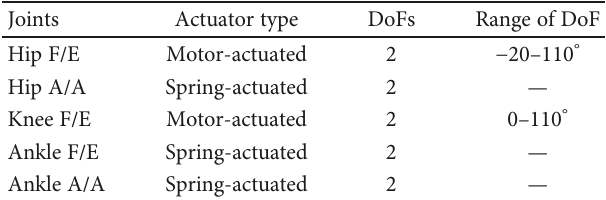
Table 1: Actuator types and parameters of